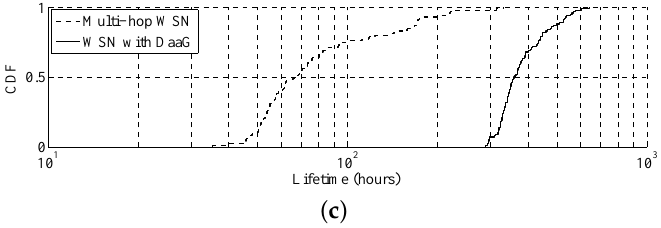
Figure 7. Cumulative distribution function of the lifetime under various network size conditions.